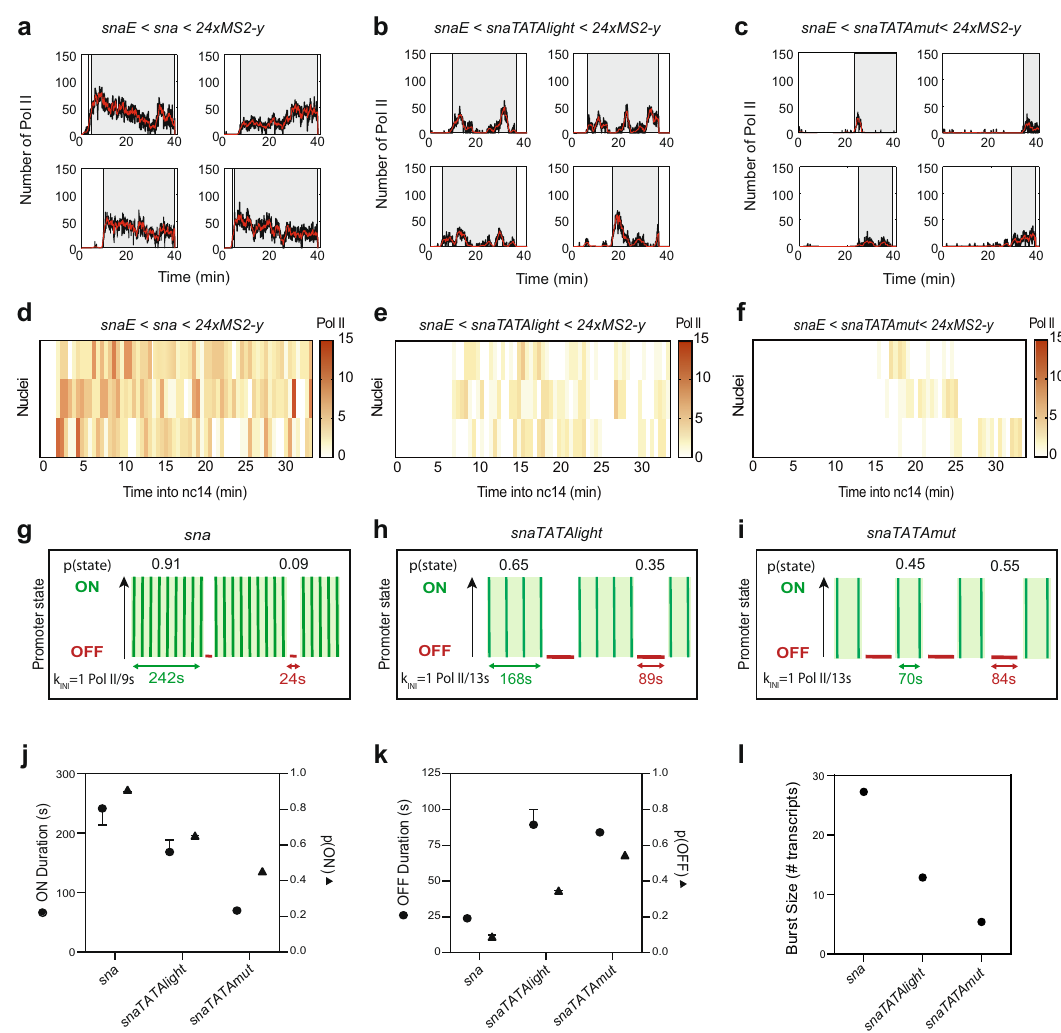
Fig. 4 TATA box motif leads to long durations of a permissive promoter state. a – c Representative traces of single-nuclei transcriptional activities for the indicated genotypes. Gray boxes indicate the analyzed transcriptional windows, black curves represent the signal expressed as the number of polymerases, and red curves represent the reconstructed signal after the deconvolution procedure. d – f Heatmaps indicating the number of polymerases during nc14 for each genotype. g – i Representation of estimated bursting parameters for sna ( g ), snaTATAlight ( h ), and snaTATAmut ( i ) promoters (see also Supplementary Table 1 and Supplementary Table 2). j Duration and probability of the permissive ON state. Error bars represent the smallest and largest values in optimal and close to optimal solutions (see “ Methods ” ). k Duration and probability of the OFF state. Error bars represent the smallest and largest values in optimal and close to optimal solutions (see “ Methods ” ). l Estimated burst size calculated as k INI /k OFF 75 using the optimal kinetic parameters (Supplementary Table 2). Statistics: snaE < sna , 216 nuclei, 3 movies; snaE < snaTATAlight , 353 nuclei, 6 movies; snaE < snaTATAmut , 21 nuclei, 3 movies. See Supplementary Movies 1 – 3 and Supplementary Table